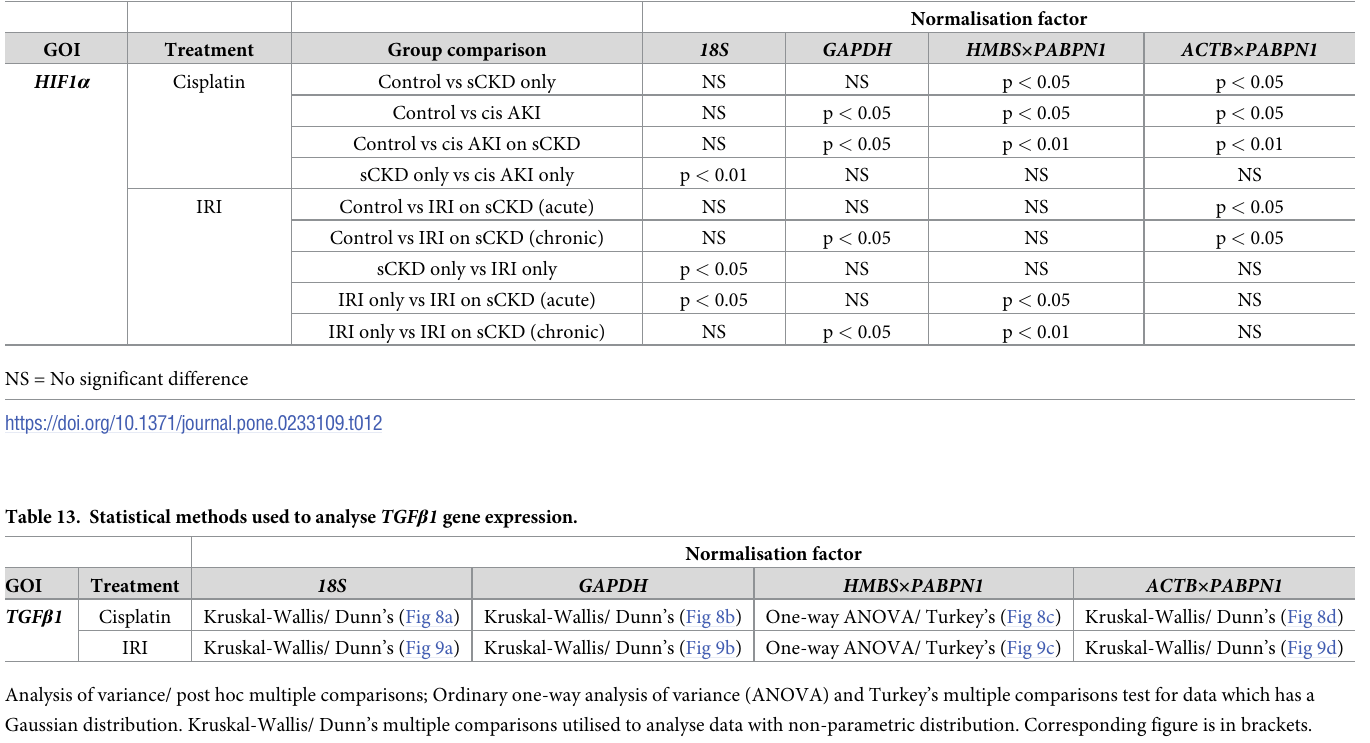
Table 12. Statistical differences of HIF1 α normalised to different reference genes and reference gene